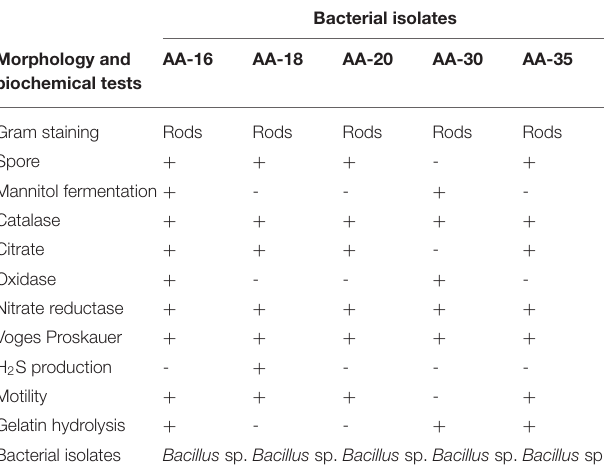
TABLE 2 | Morphological and biochemical characterization of selected bacterial isolates.